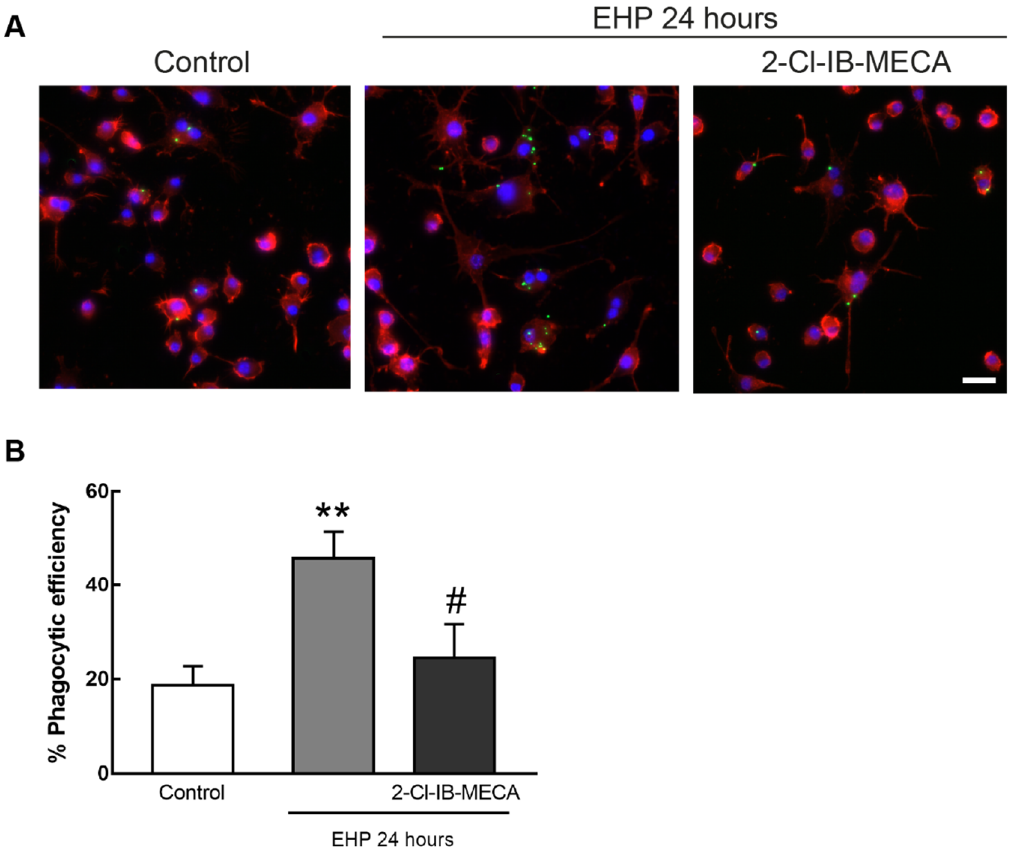
Figure 5. Effect of A 3 R activation in EHP-induced phagocytic activity of BV-2 cells. Cells were incubated with 1 µM 2-Cl-IB-MECA and then exposed to EHP for 24 h. Phagocytosis was assessed with fluorescent latex beads. ( A ) Representative images of BV-2 cells stained with phalloidin (red) with incorporated beads (green). Nuclei were stained with DAPI (blue). Scale bar: 50 µm. ( B ) Phagocytic efficiency was calculated from 4–8 independent experiments. ** p < 0.01 compared with control, # p < 0.05 compared with EHP, one-way ANOVA test, followed by Holm–Sidak’s multiple comparisons test.